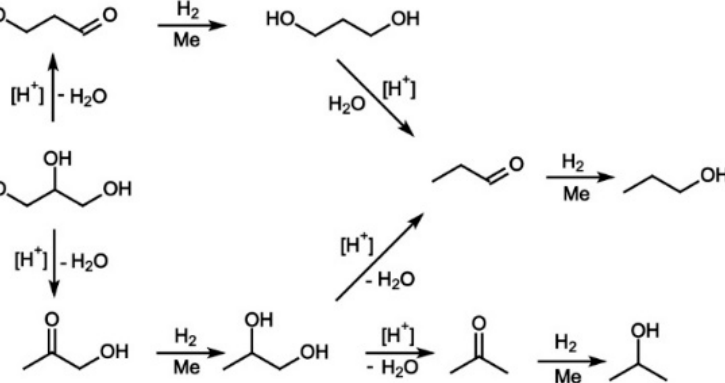
Figure 1. A possible mechanism of glycerol hydrogenolysis into 1-Pr and 2-Pr on a bifunctional catalyst. tional